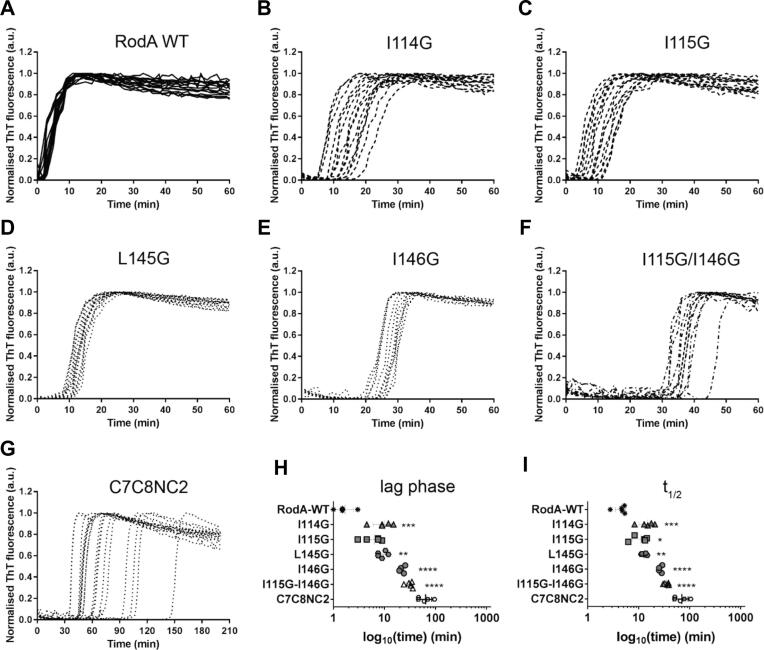
The effect of mutation(s) on the kinetics of RodA rodlet self-assembly assessed by Thioflavin T fluorescence at 50 °C. Amyloid assembly profiles for (A) RodA WT; single point mutants (B) RodA I114G, (C) RodA I115G, (D) RodA L145G and (E) RodA I146G; (F) double point mutant RodA I115G/I146G and (G) C7C8NC2 chimera. (H) Lag time and (I) time taken to reach half maximum ThT fluorescence. (See the material and methods section for calculation of lag time and time to reach half maximum).